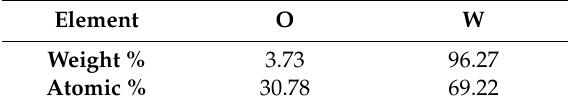
Table 2. The elemental composition of film surface presented in Figure 3a.